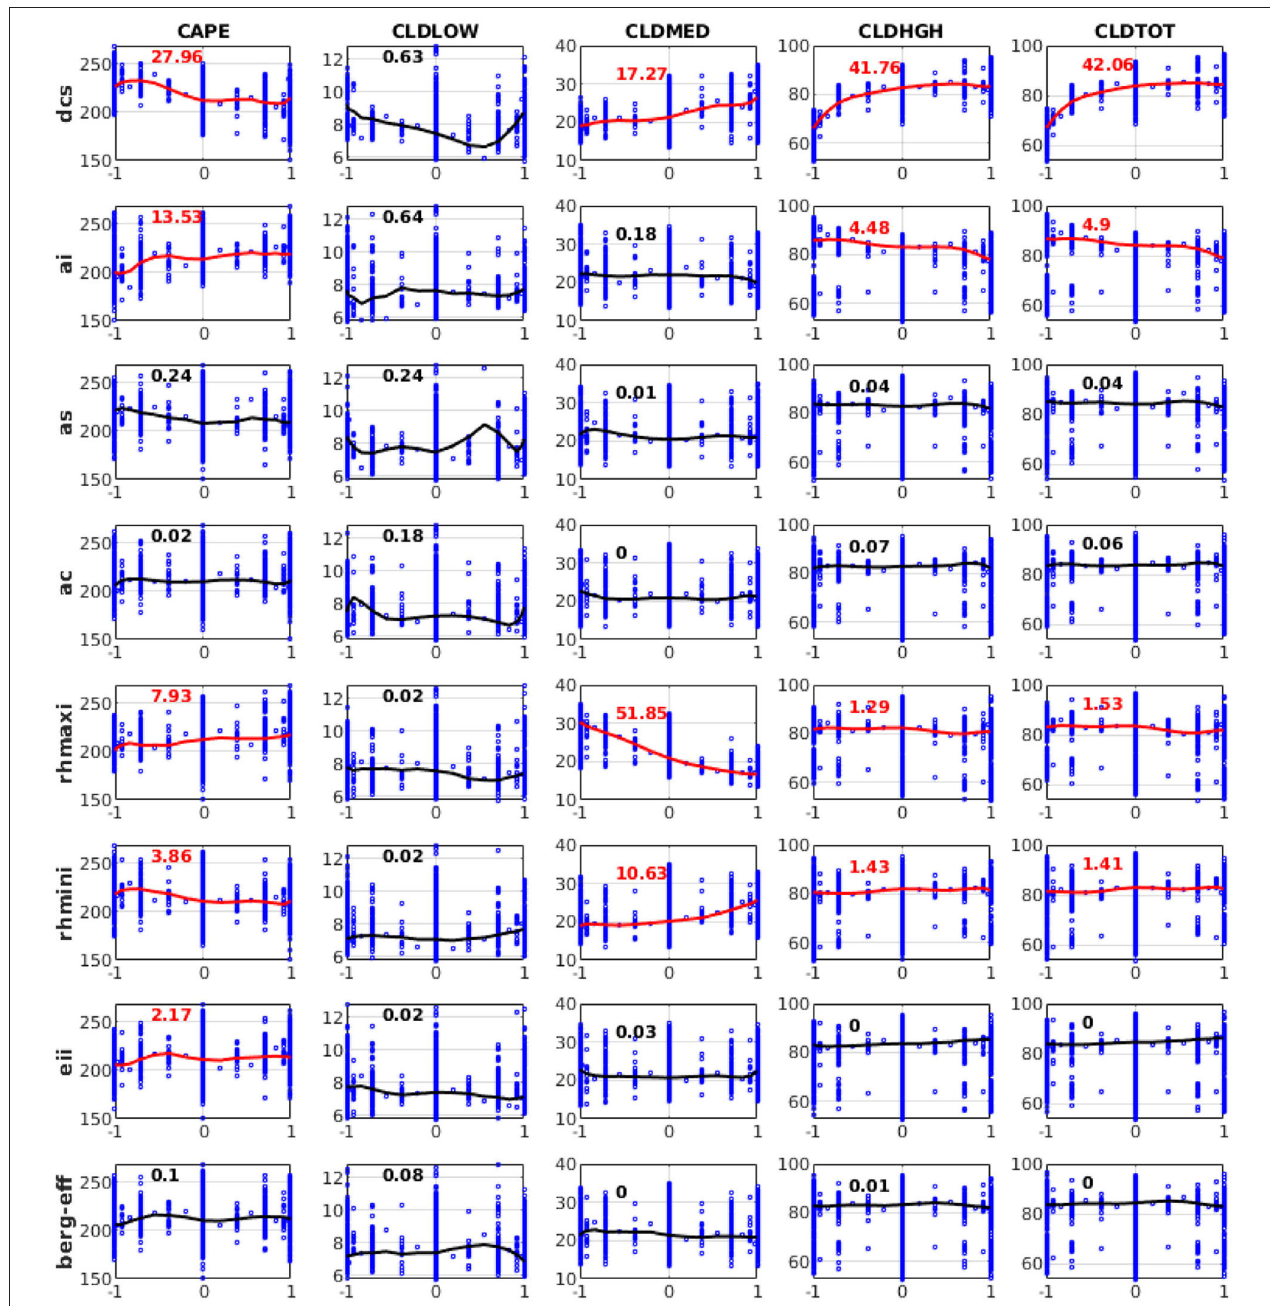
FIGURE 7 | Variation of convective available potential energy (CAPE), low-level cloud (CLDLOW), medium-level cloud (CLDMED), high-level cloud (CLDHGH), and total cloud cover (CLDTOT) in response to perturbations of eight different parameters from 3,937 SCAM6 simulations. The numbers in each plot represent the relative contributions (in %) of each input parameter perturbation to the overall variation of different variables. Red indicates that the contribution is significant ( F -test) at the 95% significance level. The line in each plot corresponds to the response effect of the perturbation of a single parameter, keeping all other parameters at the zero (central) position of the parameter uncertainty range for the simulation of that variable. Vertical bars show the range in the variation of values of a particular variable in response to the perturbation of other parameters.